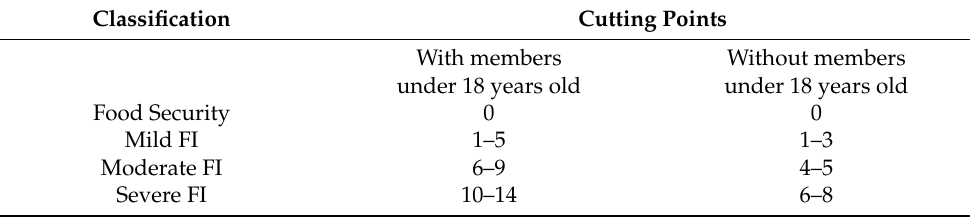
Table 1. Household classification according to Food Security categories. Classification Cutting Points With members Without members under 18 years old under 18 years old Food Security